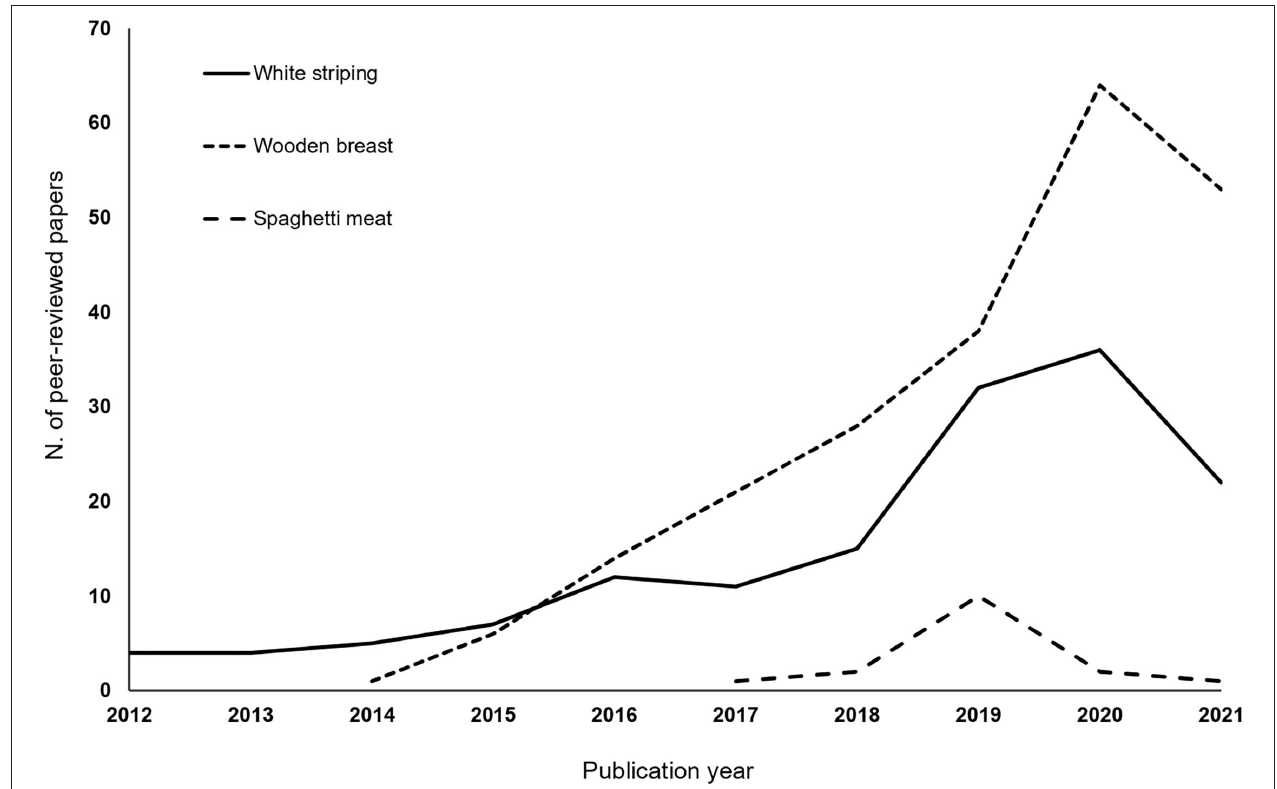
FIGURE 1 | Number of publications produced per year containing concerning white striping, wooden breast, and spaghetti meat myopathies affecting broilers’ pectoralis major muscles. Data obtained from Scopus on August 27,